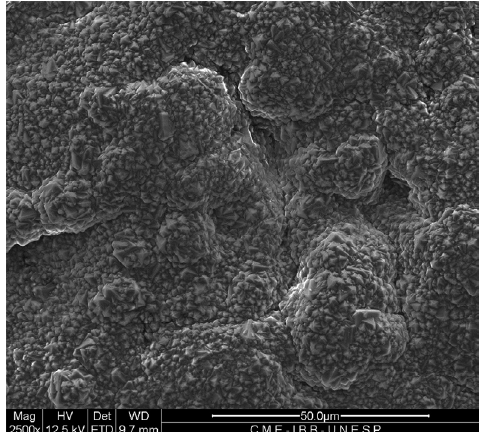
Figure 3. Surface of the sample “D”. Note that the surface is fully covered with diamond grains, including within the pores can be seen that there were the formation of